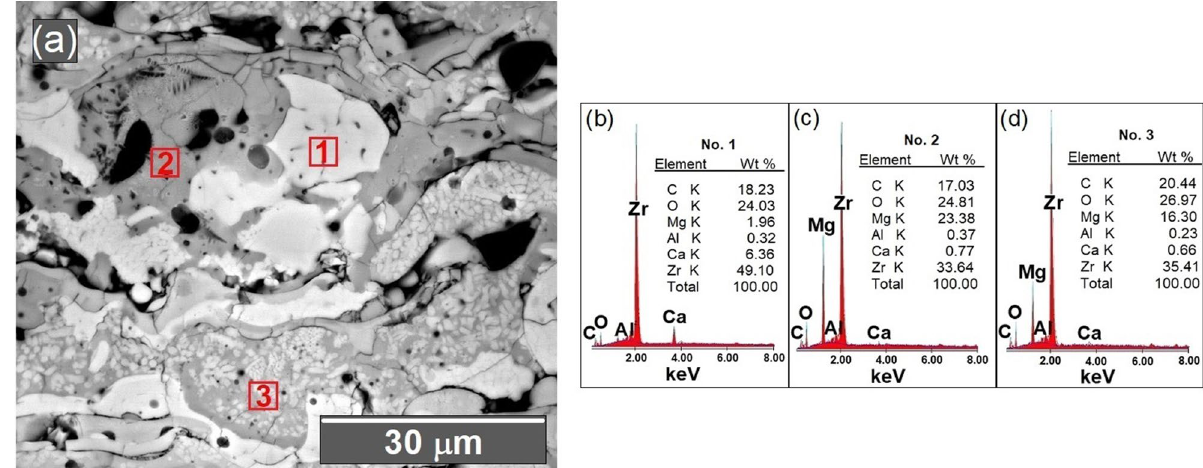
Figure 8. ( a ) Cross-sectional SEM showing microstructure of the as-sprayed mixed CSZ-MSZ top coating. Coating was performed on the substrate at plasma current of 700 A. EDX spectra in ( b ), ( c ), and ( d ) has taken on point mode at three spots marked as 1, 2, and 3 within three different regions of the coating as depicted, which shows the differences in elemental compositions in these